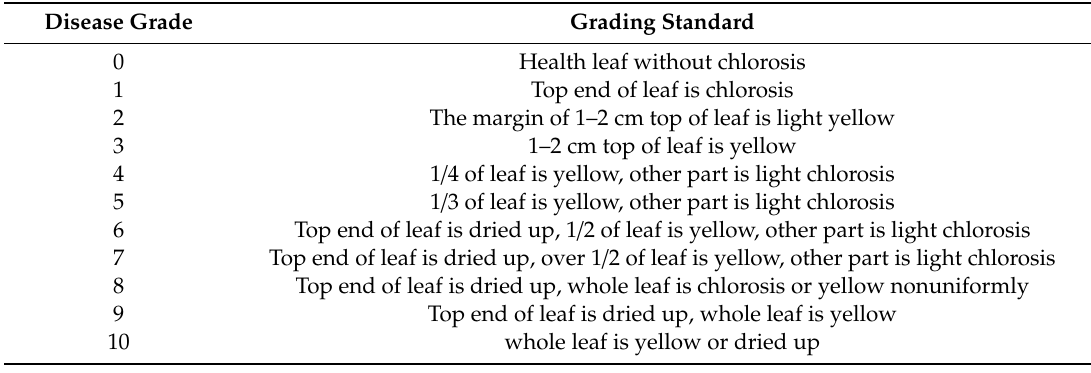
Table 1. Grade of disease leave of barley yellow dwarf virus (BYDV)-infected wheat indoor. Disease